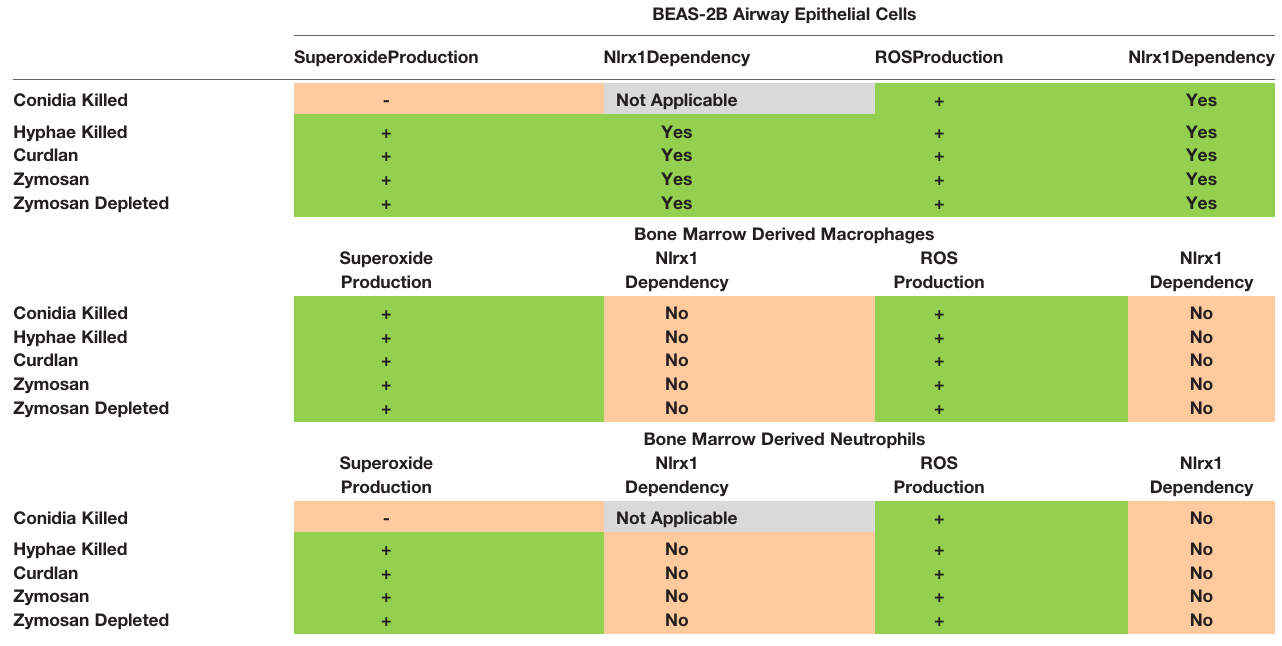
TABLE 1 | Summary of superoxide production and ROS production and their dependency on Nlrx1 in response to A. fumigatus and fungal